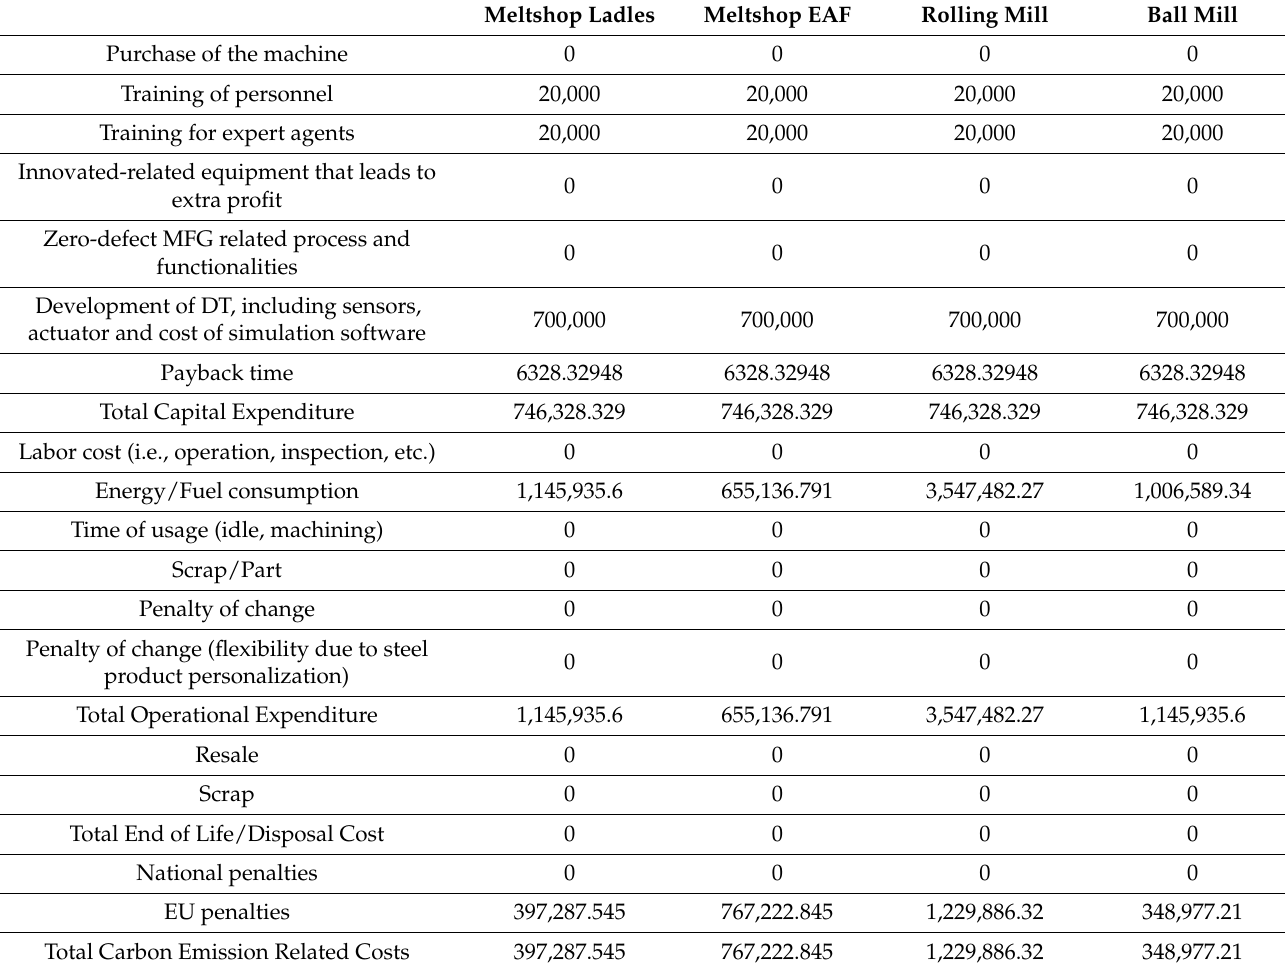
Table A2. Costs for digital tool solutions.